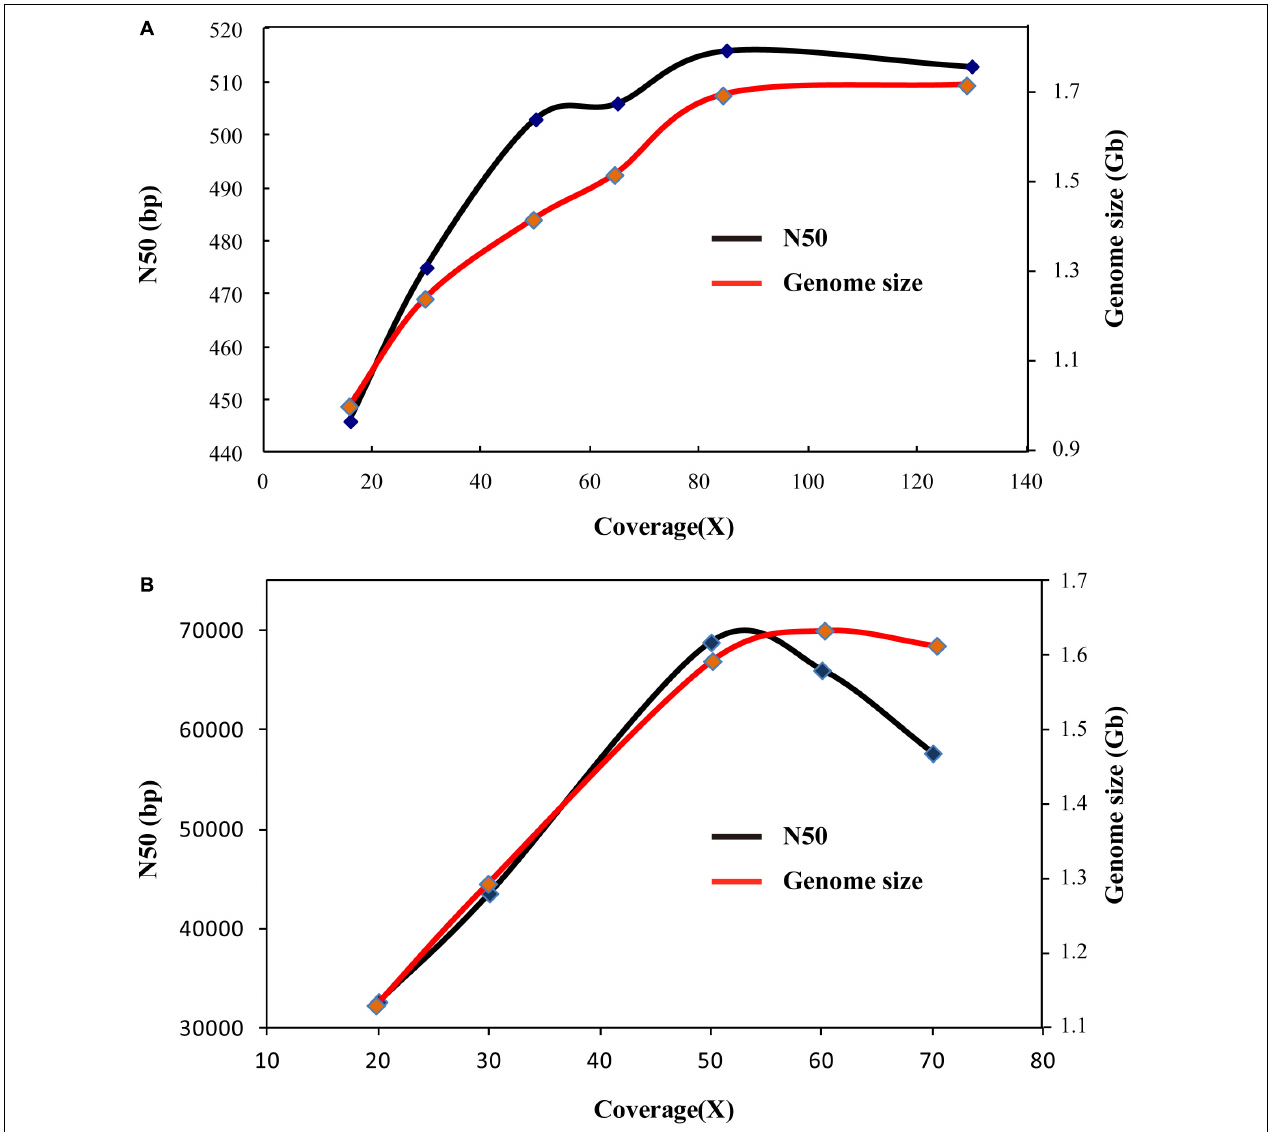
FIGURE 5 | Genome assembly using different coverages of sequencing data. (A) Genome assembly comparison using different coverages of Illumina sequencing data. (B) Genome assembly comparison using different coverages of PacBio sequencing